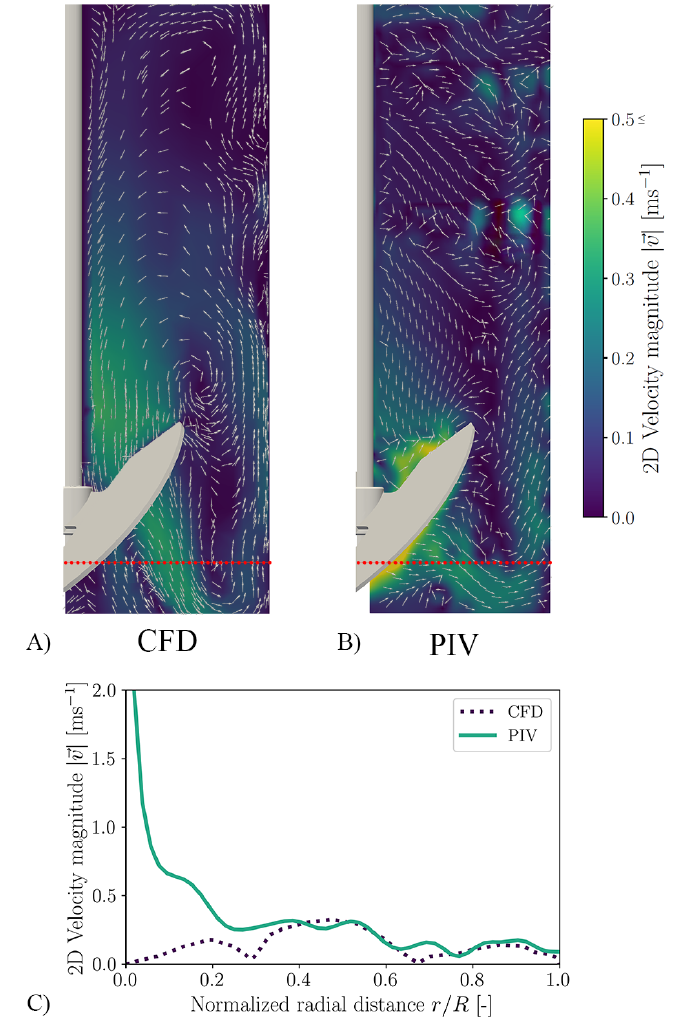
Figure 7. Validation of the CFD simulations for the Minifors 2. ( A ) shows the 2D velocity profile calculated by CFD for a stirrer speed of 180rpm and working volume of 4L. ( B ) shows the measured 2D velocity profile using PIV. The shown colour bar applies to both. ( A – C ) illustrates the difference between the velocity profiles at a height of 0.05m from the bottom of the reactor (red line in ( A , B )). If the validated CFD model is used to determine the specific power input, the charac- teristic pattern for stirred reactors appears, namely, the specific power input being a power function of the stirrer speed [42]. For the Minifors 2, only power inputs are published, which were also determined using CFD [127]. As shown in Figure 8, the specific power inputs determined here correspond to those from the literature [127]. The specific power in- put increases from 11.4 W m − 3 ( N = 100 rpm, Re m = 13 474) to 1155.3 W m − 3 ( N = 500